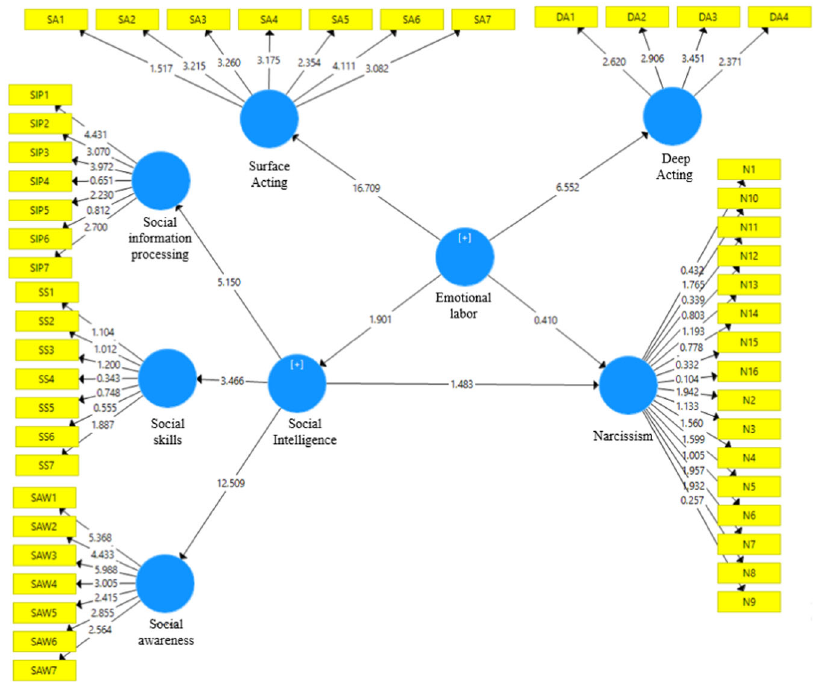
Fig. 4 Structural Equation Modelling Results (SEM) for testing hypotheses H5, H6. Structural model results. Table 6 Direct and indirect effects between social intelligence, deep acting, surface acting, emotional labour, and narcissism. Effect